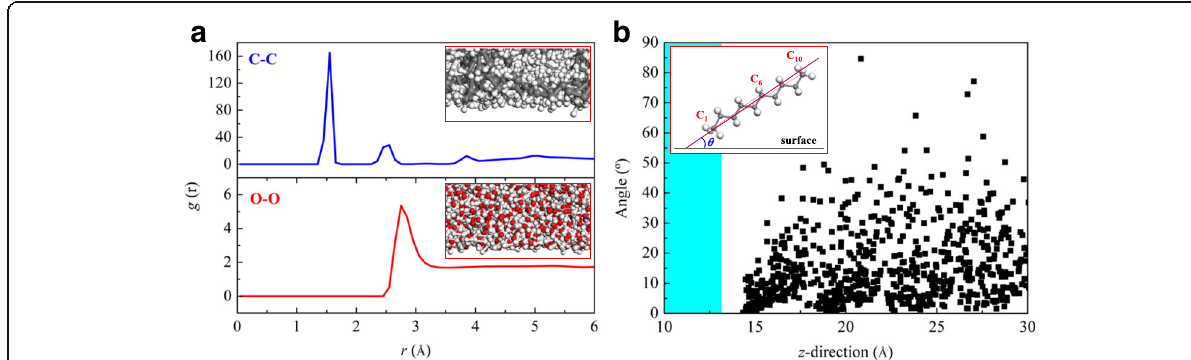
Fig. 7 Molecular structures on the neutral silicon dioxide surface. a RDF distributions of oil and water molecules. b Orientations of oil molecules located at different heights in the z